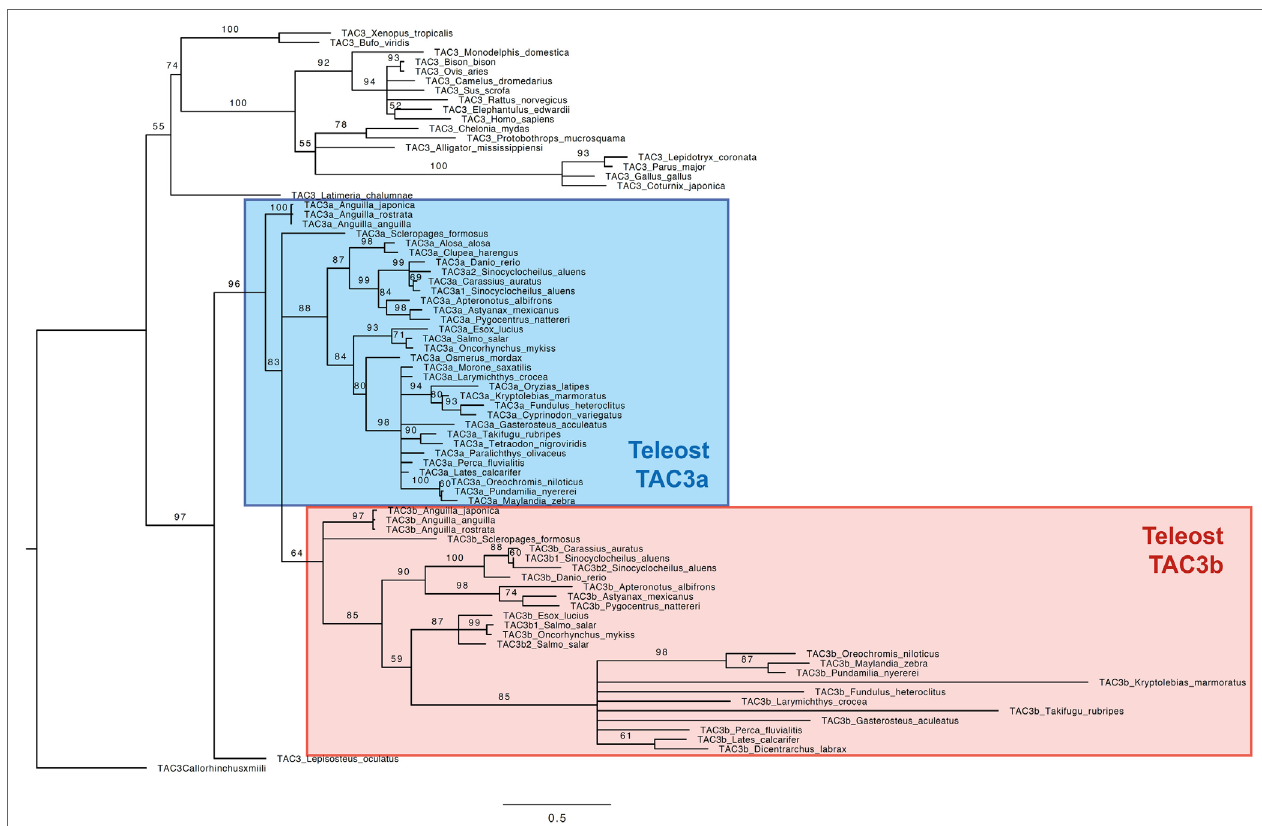
FigUre 2 | Consensus phylogenetic tree of vertebrate TAC3 pre-pro-peptide amino acid sequences. This phylogenetic tree was based on the deduced amino acid sequences of tac3 (see Table S1 and Figure S1 in Supplementary Material) using the maximum likelihood method with 1,000 bootstrap replicates. The number shown at each branch node indicates the bootstrap value (%); only values and branching above 50% are indicated. The tree was rooted using the TAC3 sequence of the elephant shark Callorhinchus milii . The teleost TAC3a and TAC3b sequences are colored in blue and red,